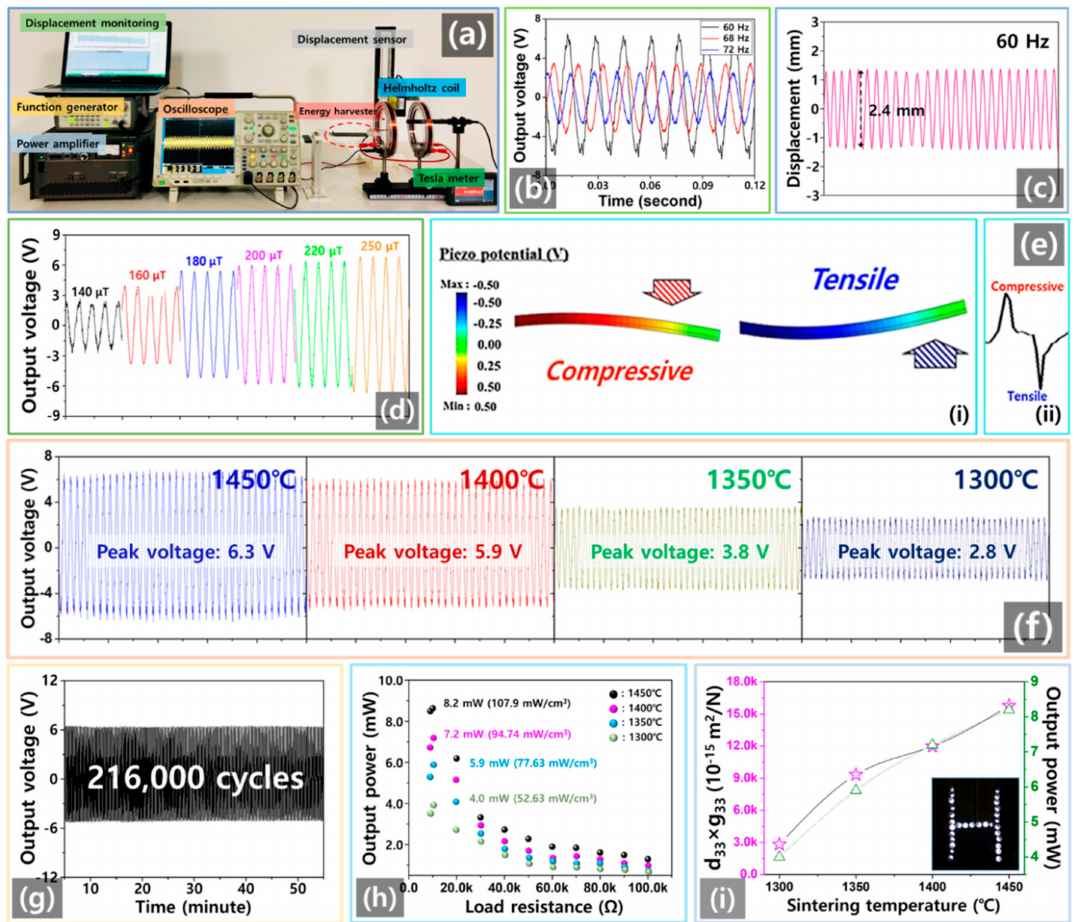
Figure 3. ( a ) Photograph of the experimental environment used to observe the power-generation characteristics of the LPEH in various magnetic fields ( µ T). ( b ) Open-circuit output voltage (V) of the LPEH at various frequencies. ( c ) Displacement of the LPEH at a resonance frequency of 60 Hz. ( d ) Open-circuit output voltage (V) of the LPEH in differential magnetic fields ( µ T). ( e ) Simulated data of the piezoelectric potential (V) when stress is applied. ( f ) Open-circuit output voltage (V) characteristics of LPEHs composed of BCTZC 0.3 films processed at various sintering temperatures ( ◦ C). ( g ) Open- circuit output voltage of the LPEH for a durability test of over 216,000 cycles performed in a magnetic field of 250 µ T. ( h ) Instantaneous maximum output power (mW) values of LPEHs with BCTZC 0.3 films sintered at various temperatures ( ◦ C) under specific load resistances ( Ω ) for impedance matching. ( i ) Power conversion constant ( d 33 × g 33 ) and instantaneous maximum output power (mW) values of LPEHs with BCTZC 0.3 films, depending on their sintering temperatures ( ◦ C). The inset shows lighting when using 30 white light-emitting